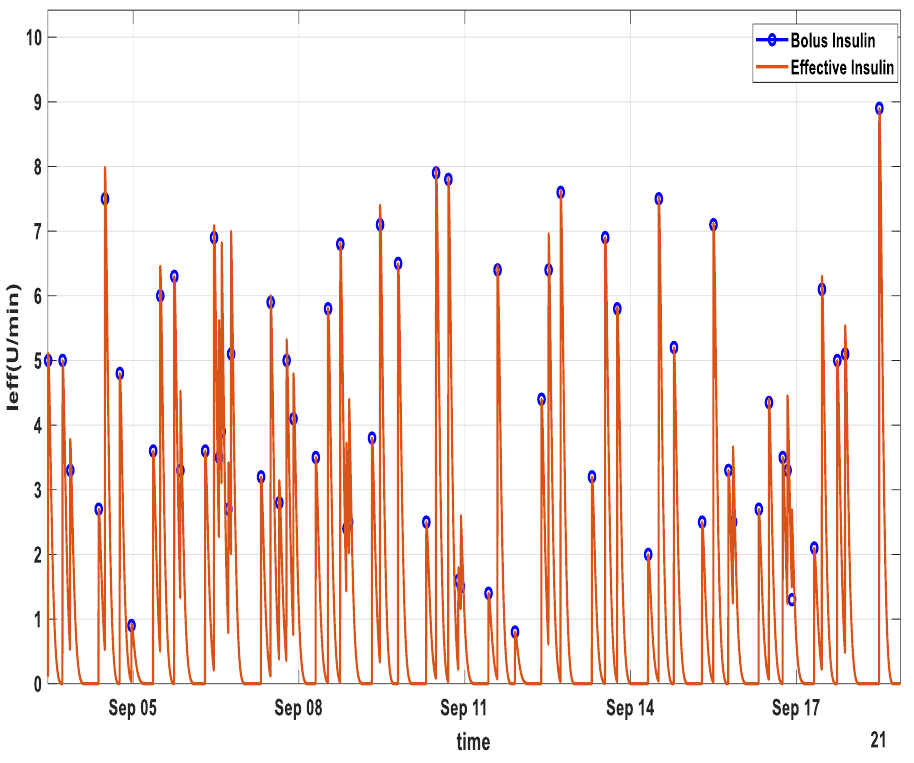
Figure 8. Bolus insulin transformation into active insulin for patient ID 570 over a period of 5 days. Blue circles represent the time and amount of bolus insulin, whereas the brown curves represent the transformation into active insulin over the next 6 h.